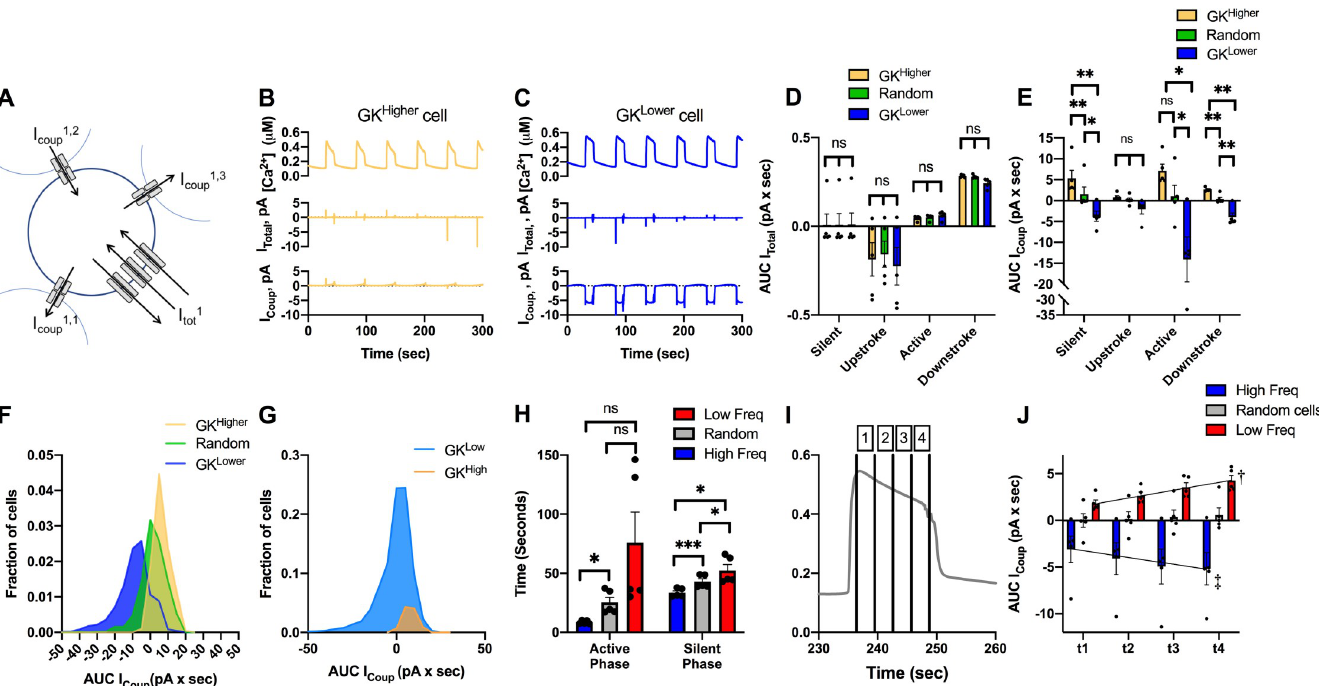
Fig 7. Gap junction current in cells with high/low metabolic activity or oscillation frequency. A). Schematic of cell within the simulated islet, showing 3 gap junction currents that contribute to the total gap junction current, together with the total membrane current. B). Time course of [Ca 2+ ] from a cell, together with the total membrane current and total gap junction current for a representative cell with higher metabolic activity (k glc ). C). As in B for a representative cell with lower metabolic activity. D). Total membrane current, as expressed by an area under the curve (AUC), for each phase of the [Ca 2+ ] oscillation averaged over the 10% of cells with highest or lowest k glc or a random 10% of cells. E). As in D for total gap junction current. F). Distribution of total gap junction current, as expressed by AUC, for the 10% of cells with highest or lowest k glc or a random 10% of cells. G). As in E for a bimodal distribution in k glc . H). Mean duration of active phase and silent phase averaged over the 10% of cells with highest or lowest oscillation frequency, or a random 10% of cells. I). Mean islet [Ca 2+ ] time course showing different portions of the active phase (1–4). J). Mean islet gap junction current during different portions of the active phase, as indicated in I for the 10% of cells with highest or lowest oscillation frequency, or a random 10% of cells. Black lines are fitted regression lines. Error bars are mean ± s.e.m. Repeated measures one-way ANOVA was performed for data in D, E, H to test for significance. Linear regression was performed on data in J. Significance values: ns indicates not significant (p > .05), � indicates significant difference (p < .05), �� indicates significant difference (p < .01), ��� indicates significant difference (p < .001), ���� indicates significant difference (p < .0001), † indicates significant linear regression (p < .05), ‡ indicated significant linear regression (p < .01). Data representative of 5 simulations with differing random number